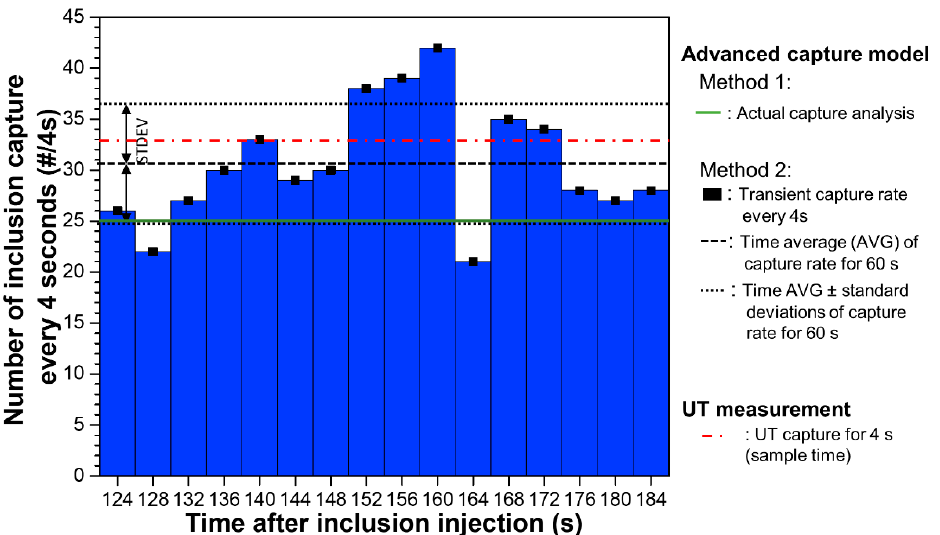
Figure 15. Capture rate of large inclusions ( ≥ 300 µ m) in the capture band of the steel sample, comparing the particle capture modeling (histogram and black line) with the UT measurements (horizontal red line).